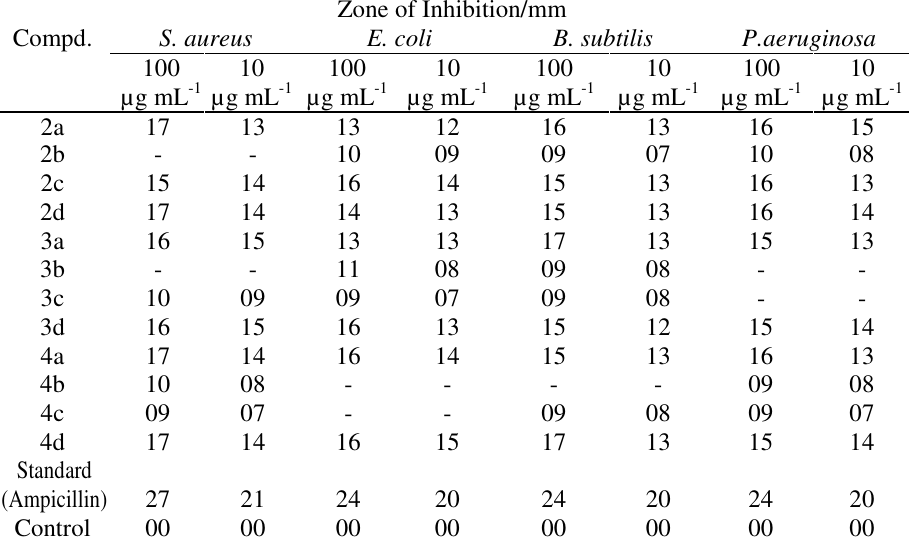
Table 1. Evaluation of antibacterial activity of the compounds. Zone of